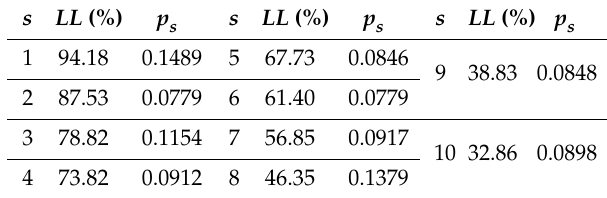
Table 8. Load Table 8. Load Scenarios.